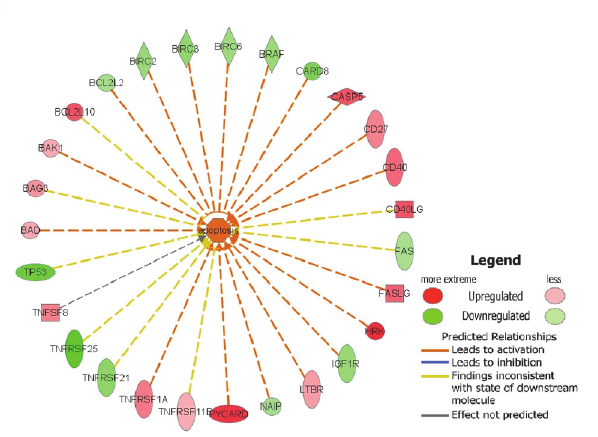
Fig 1. Gene network. Ingenuity analysis for the genes that stimulated/inhibited apoptosis in Hs578T cell line.